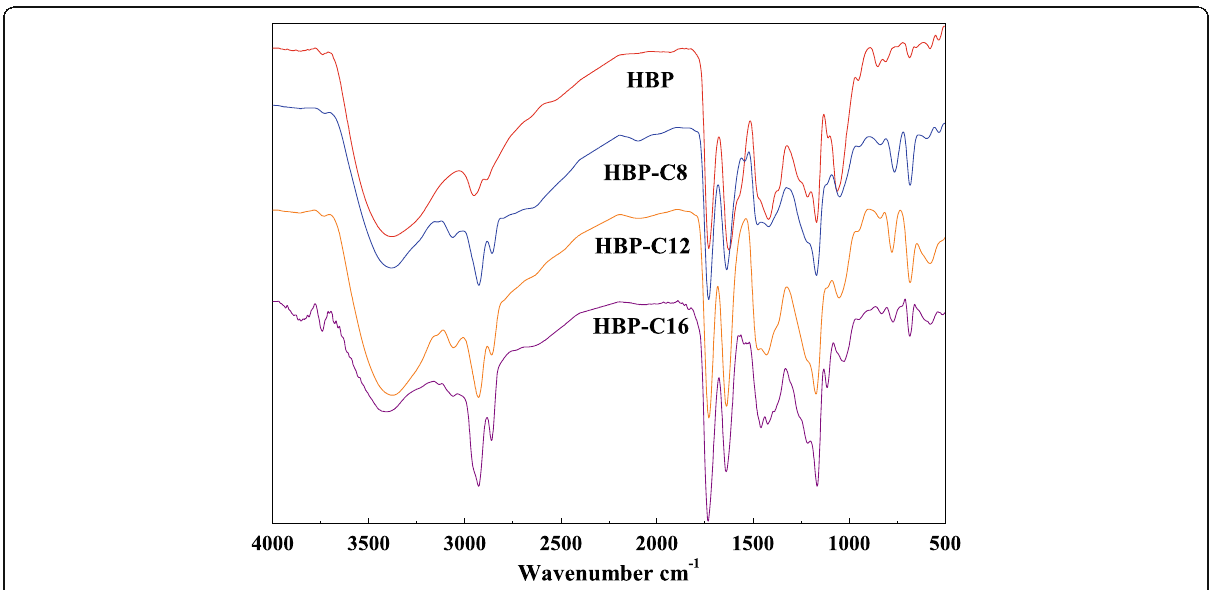
Fig. 3 FTIR spectra of HBP and